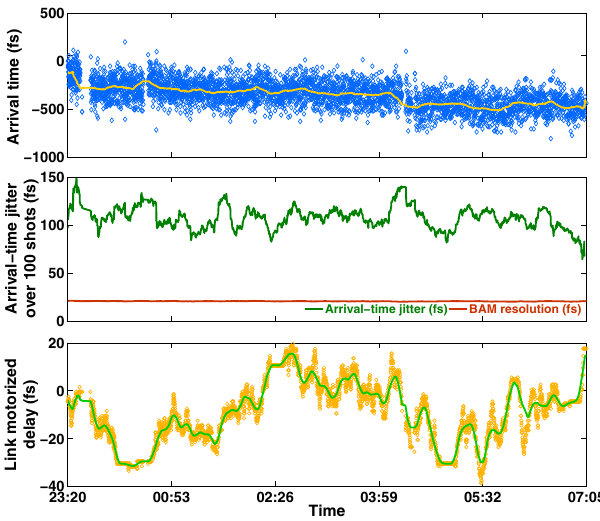
FIG. 53. Long-term bunch arrival-time measurement over a period of eight hours, using the BAM upstream of the bunch compressor at a bunch charge of 130 pC (top), arrival-time jitter over 100 shots (middle) with instantaneous resolution (red curve), and link length compensation applied by the motorized delay line